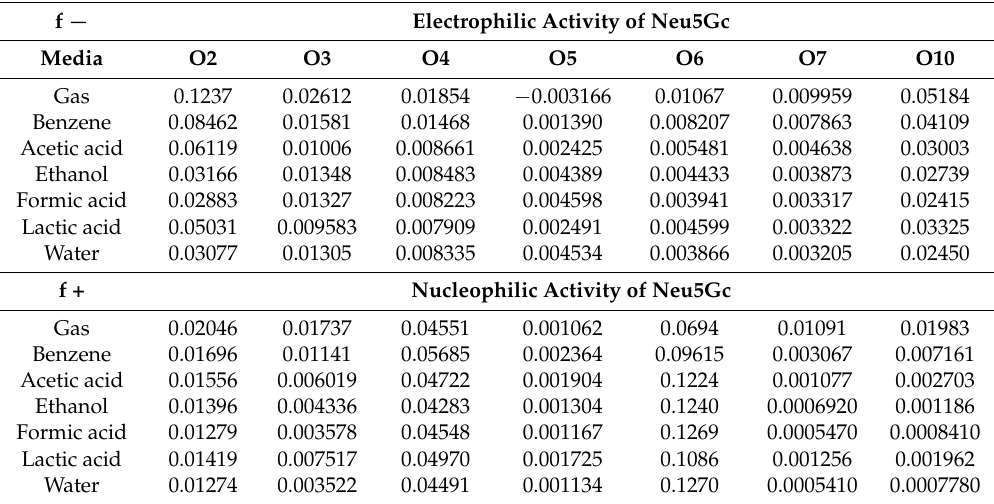
Table 3. Condensed Fukui function of Neu5Gc at the M062X/6-311G(d,p) level, keep four significant